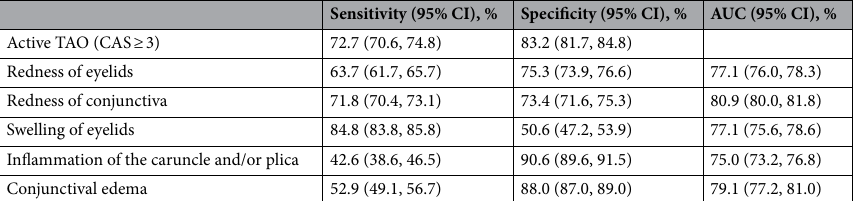
Table 2. Diagnostic accuracy of a ML-assisted system for active TAO and each inflammatory sign of CAS in the test set constructed from entire dataset. ML machine learning, CI confidence interval, AUC area under the curve, TAO thyroid associated orbitopathy, CAS clinical activity score.